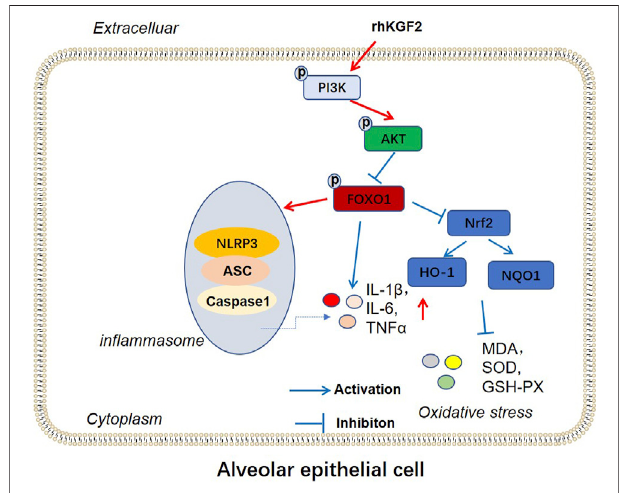
FIGURE 8 | The mechanism diagram. rhKGF2 enhanced the activation of PI3K/AKT pathway, inhibited the phosphorylation of FoxO1, thus repressingNLRP3-ASC-Caspase1in fl ammasomeand promotedNrf2/HO-1/ NQO1axis. Finally,rhKGF2 repressed in fl ammation and oxidative stress of alveolar epithelial